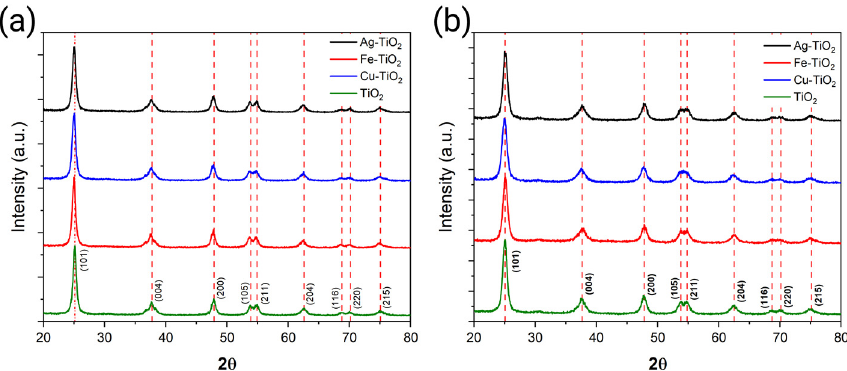
Figure 3. X-ray diffraction patterns of ( a ) SG-synthesized and ( b ) Mw-SG-synthesized materials. Table 1. Crystallite size by Scherrer and Williamson-Hall method and degree of crystallinity for the SG- and Mw-SG-synthesized